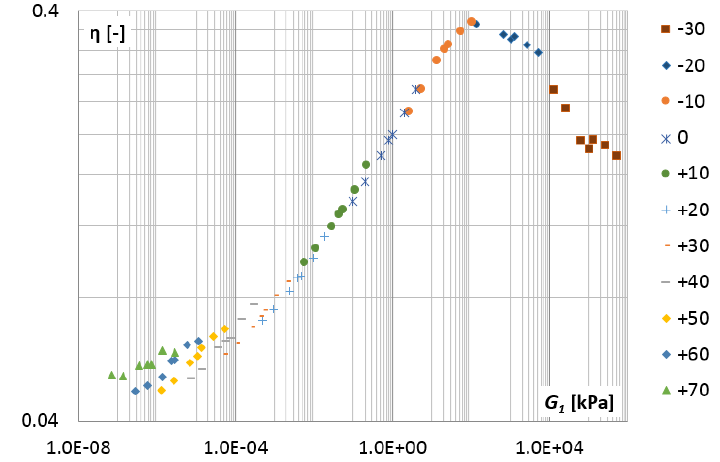
Figure 15. The wicket plot, the loss factor η = tan ( δ ) vs. storage modulus G 1 ( λ i ) for selected temperatures.